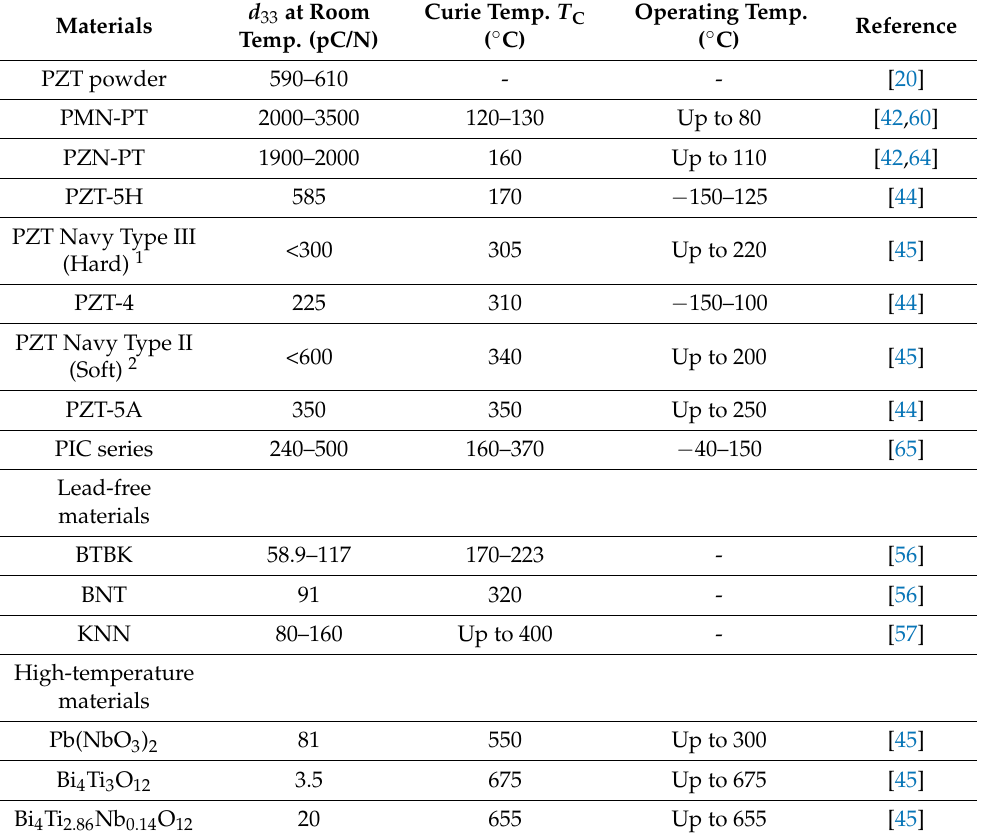
Table 1. Examples of some properties of piezoelectric materials.